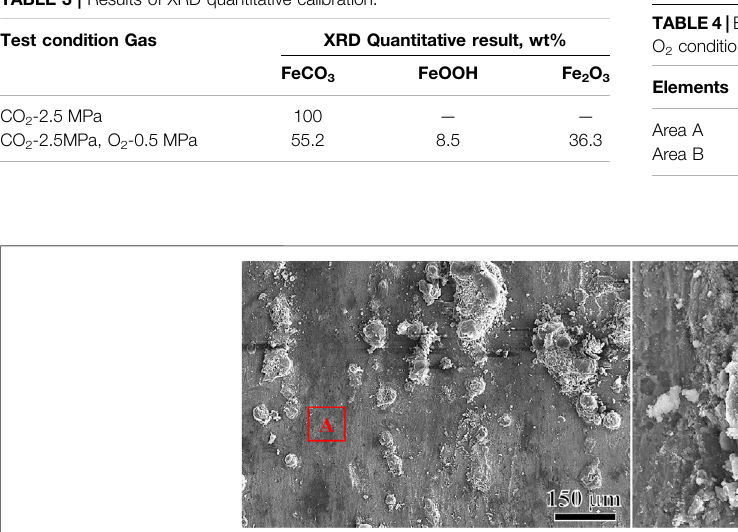
TABLE 3 | Results of XRD quantitative calibration.